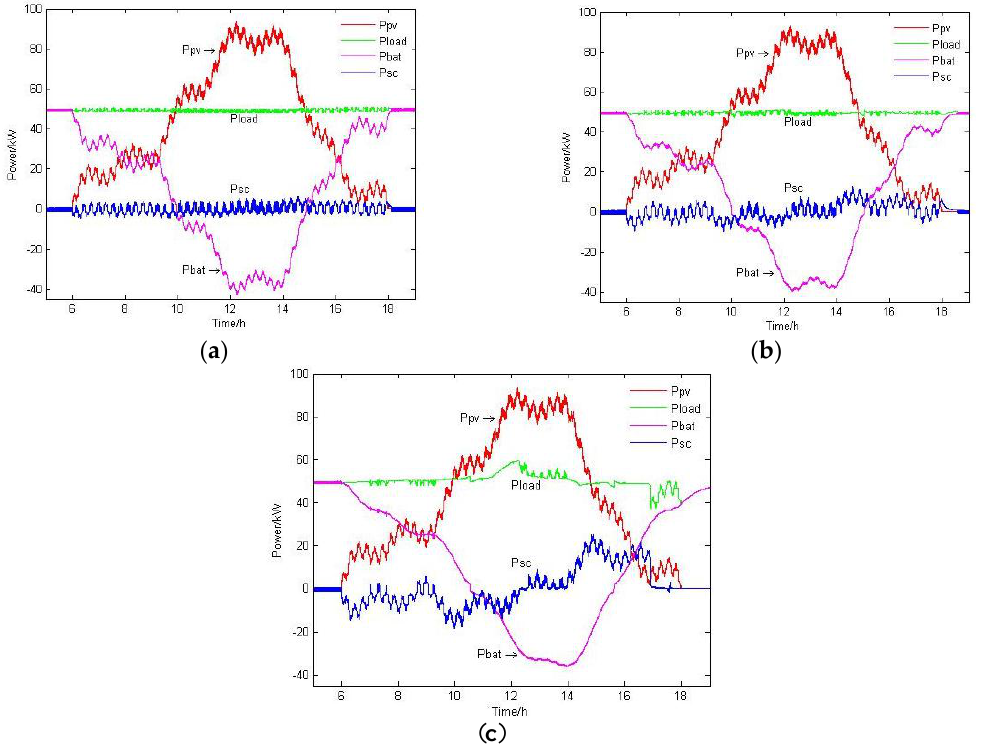
Figure 11. Output waveforms for different time constants for long time scale. ( a ) T = 150 s; ( b ) T = 600 s; ( c ) T = 2400 s.